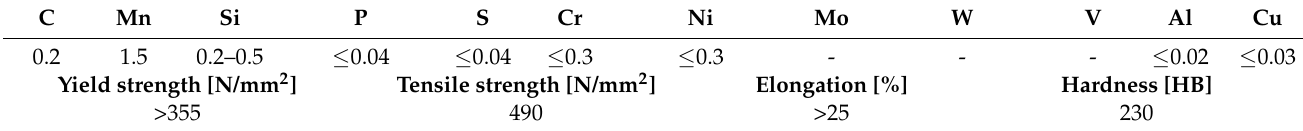
Table 2. Chemical composition in % of weight and typical mechanical properties of S355J2